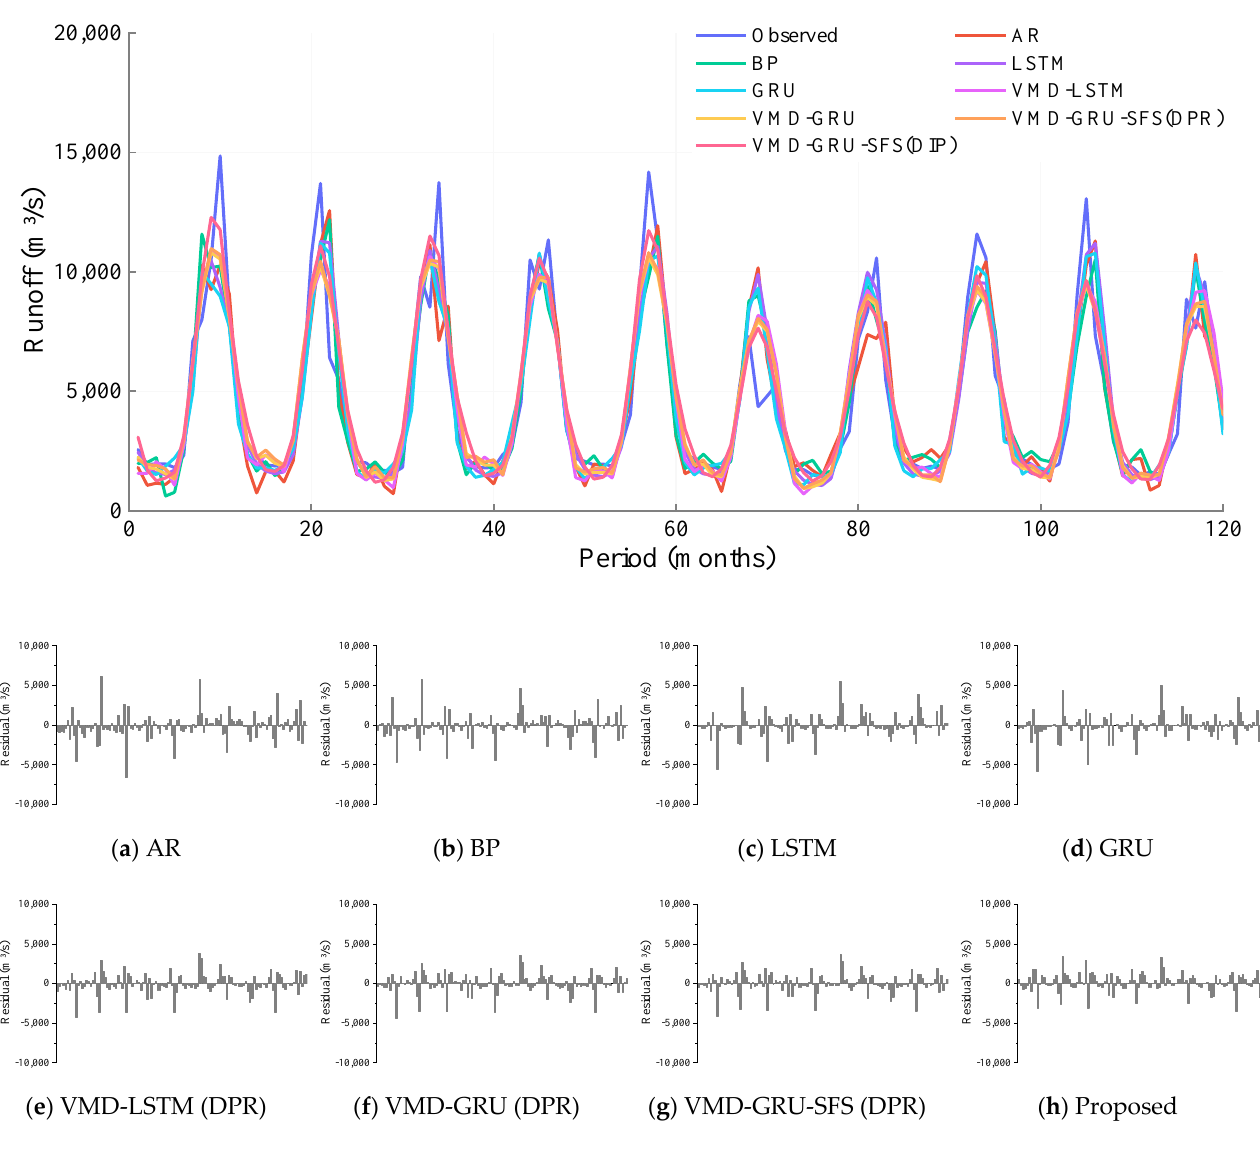
Figure 5. Prediction results and residual of different methods for the Pingshan station. ( a ) AR model prediction residual; ( b ) BP model prediction residual; ( c ) LSTM model prediction residual; ( d ) GRU model prediction residual; ( e ) VMD-LSTM (DPR) model prediction residual; ( f ) VMD-GRU (DPR) model prediction residual; ( g ) VMD-GRU-SFS (DPR) model prediction residual; ( h ) Proposed model prediction residual.